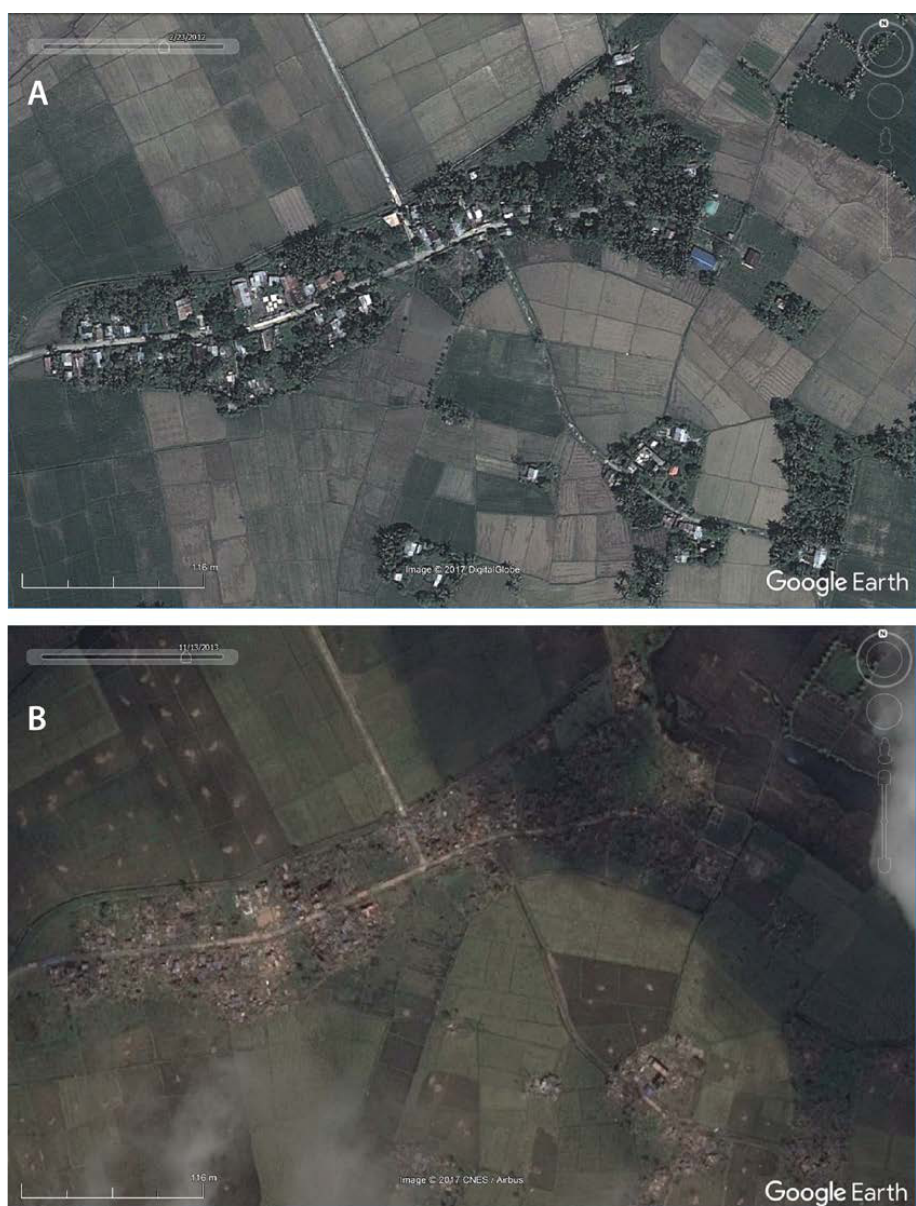
Figure 2. ( A ) Digital Globe image (23 February 2012) courtesy of Google Earth showing the community of Badiangay prior to Typhoon Haiyan. ( B ) CNES/Airbus image (13 November 2013) courtesy of Google Earth showing the community five days after Typhoon Haiyan passed through.